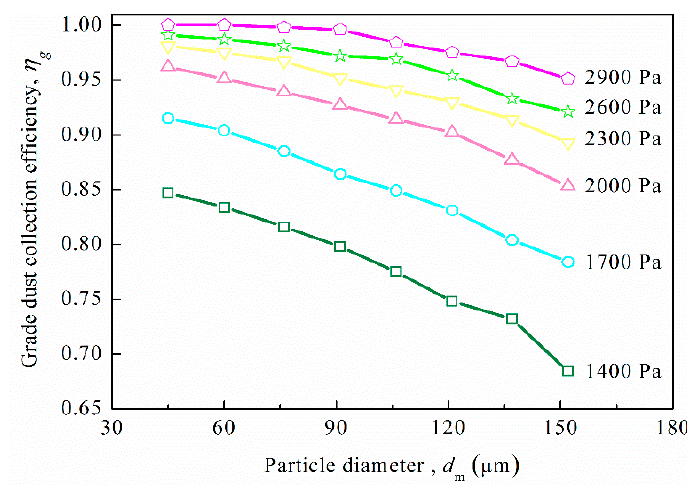
Figure 10. Influence of pressure drop on the grade dust-collection efficiency. Processes 2020 , 8 , x FOR PEER REVIEW